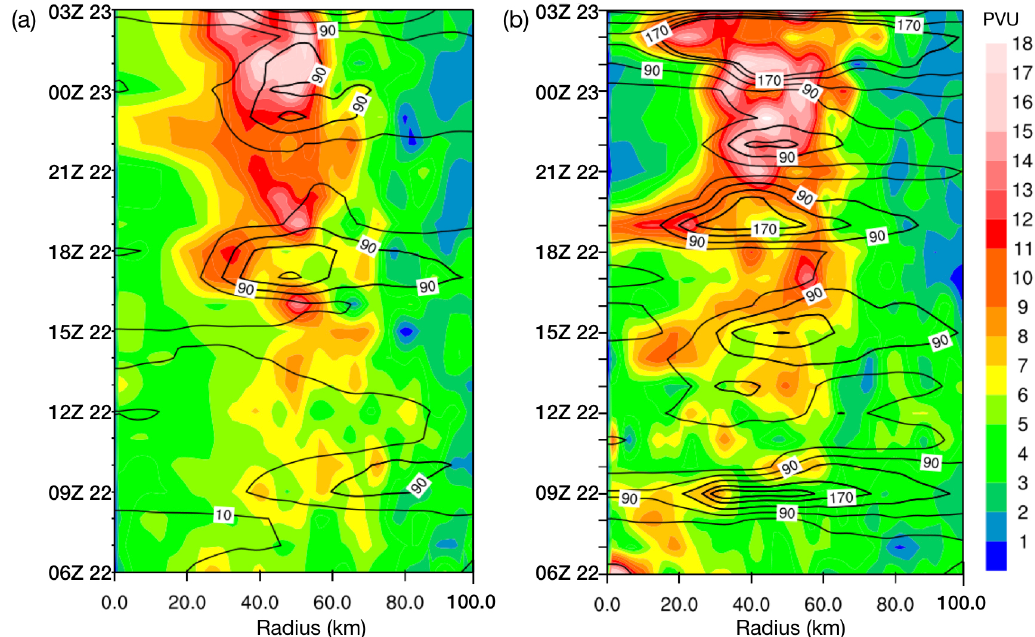
Figure 15. Radial-time cross section of the azimuthally averaged PV (shaded, unit: PVU, i.e., 10 − 6 m 2 s − 1 K kg − 1 ) and EKE (contours, unit: m 2 s − 2 ) on the level of 6 km for ( a ) CPL experiment and ( b ) FO experiment, respectively. Ordinate values are time from 0600 UTC on 22 August to 0300 UTC 23